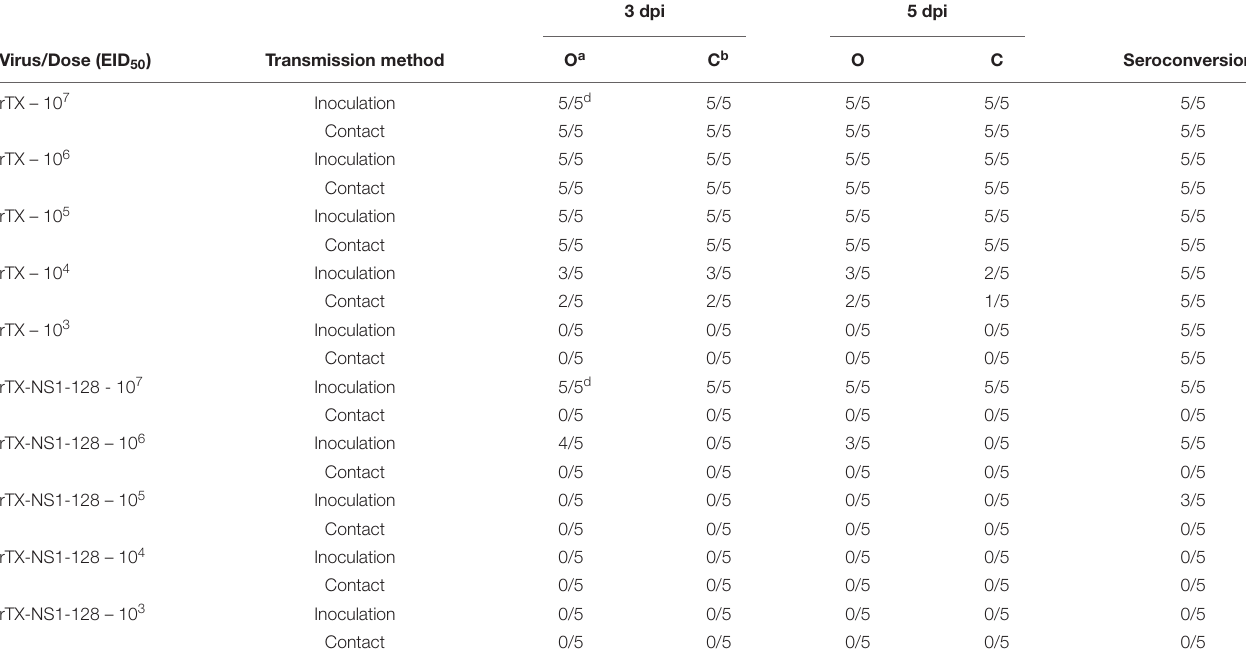
TABLE 3 | Transmission and dose-response study of wild-type H9N2 (rTX) and NS1-truncated H9N2 (rTX- NS1-128) viruses in